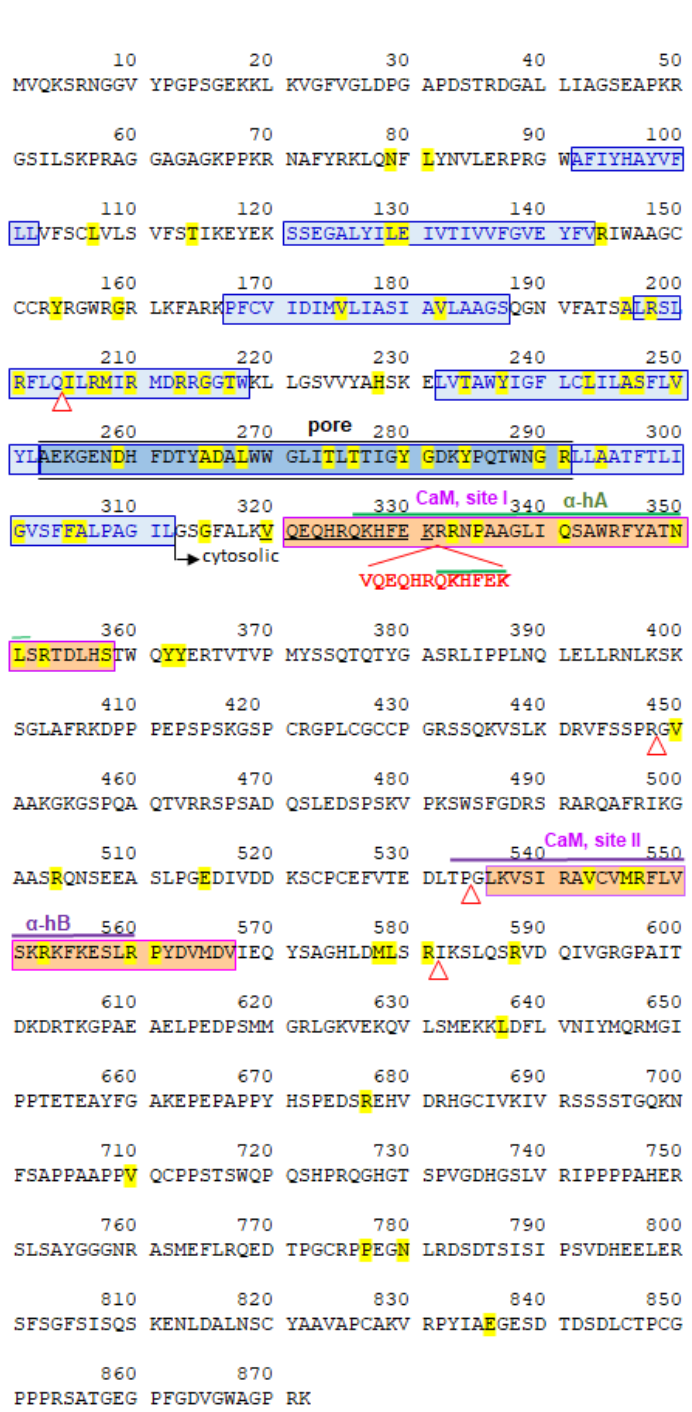
Figure 2. Partial duplication of exon 7 KCNQ2 in the calmodulin interaction site. The twelve duplicated amino acids are underlined, and the inserted peptide is indicated in red. In the sequence, the amino acids in yellow indicate the 73 residues a ff ected by the pathogenic variants reported in 159 di ff erent patients obtained from the ClinVar database and publications referenced in the text. The human KCNQ2 protein reference is UniProtKB (O43526-1). The triangles indicate short deletions or insertions that caused a change in reading frame and a truncated protein. Information in blue boxes indicates the transmembrane domain (TM). The pore region is indicated with the black line. Information in purple indicates the two regions that interacted with calmodulin (CaM) that have two alpha helixes ( α -hA in green and α -hB in dark purple).